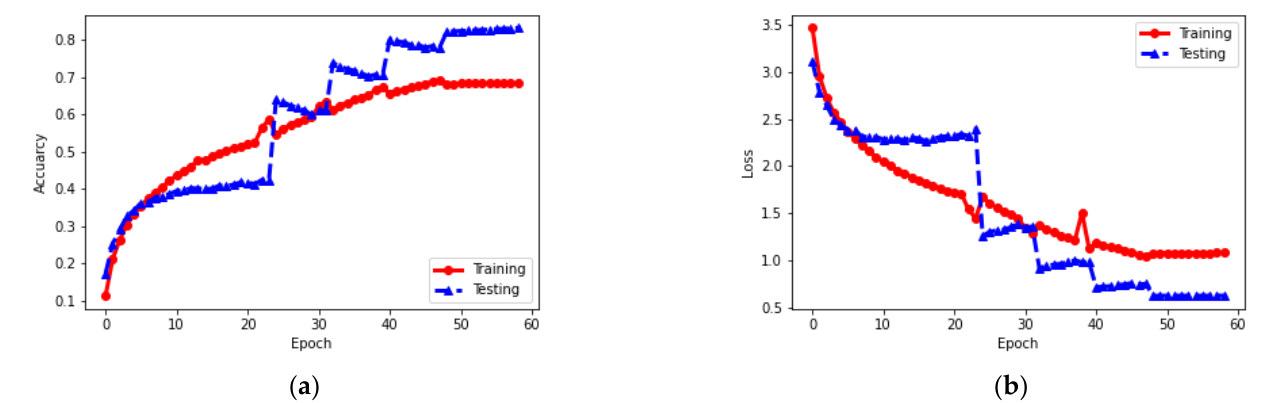
Figure 5. Performance accuracy and loss curves over epoch on the Twitter50 dataset: ( a ) accuracy,